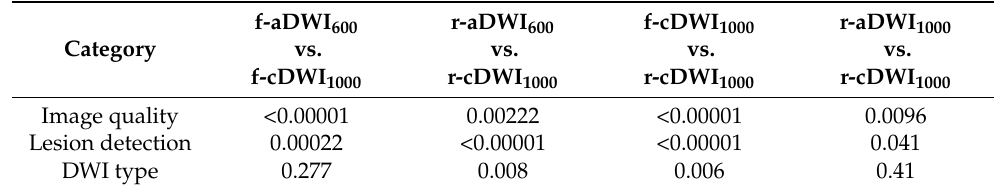
Table 2. Results of p -values for comparison of qualitative image parameters. The labeling was